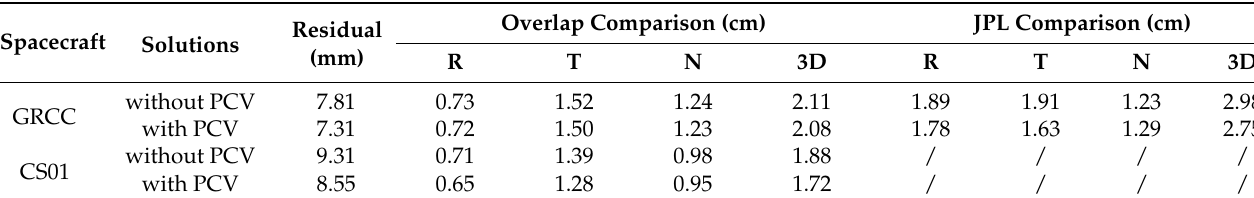
Figure 11. RMS of orbital differences for GRCC and CS01 with/without PCV corrections. Table 4. The RMS of residual and orbital comparison with/without PCV for GRCC and CS01.